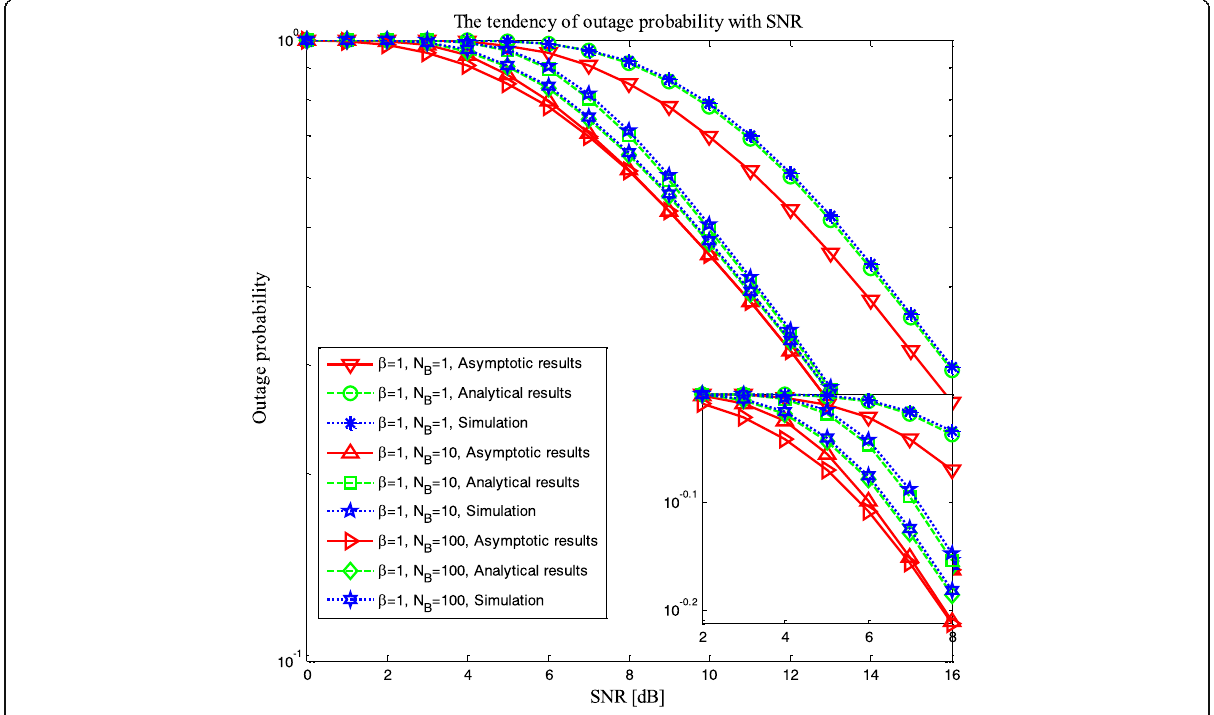
Fig. 5 The tendency of outage probability with SNR